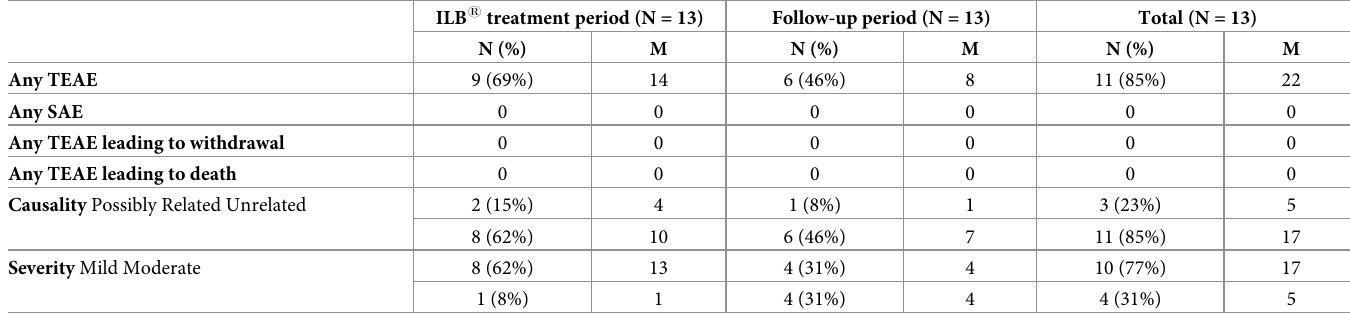
Table 6. Adverse event data (TEAE = treatment related adverse events; SAE = serious adverse events; N = Number of patients; M = number of events).